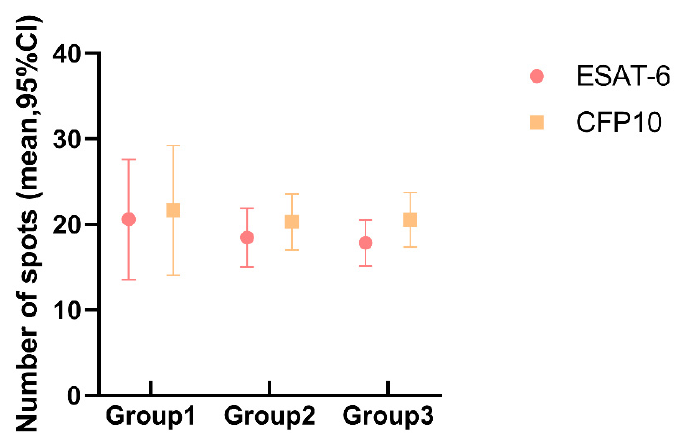
Figure 2. The comparison of different groups with different IGRA assays. Group 1: CD4 + T cell number of <200/ µ L; Group 2: CD4 + T cell number of 200–500/ µ L; Group 3: CD4 + T cell number of >500/ µ L; *: p ≤ 0.05.